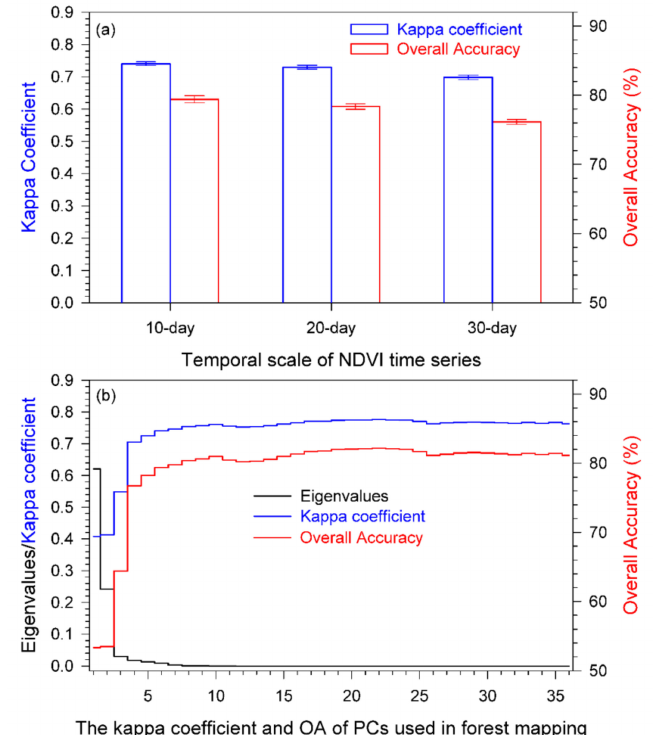
Figure 5. The identification accuracy of dominant tree species based on NDVI time series data of di ff erent temporal scales ( a ), and the eigenvalues of principal component analysis (PCA) based on 10-day NDVI time series, and the kappa coe ffi cient and overall accuracy (OA) of dominant tree species identifications considering the number of PCs in the analysis ( b